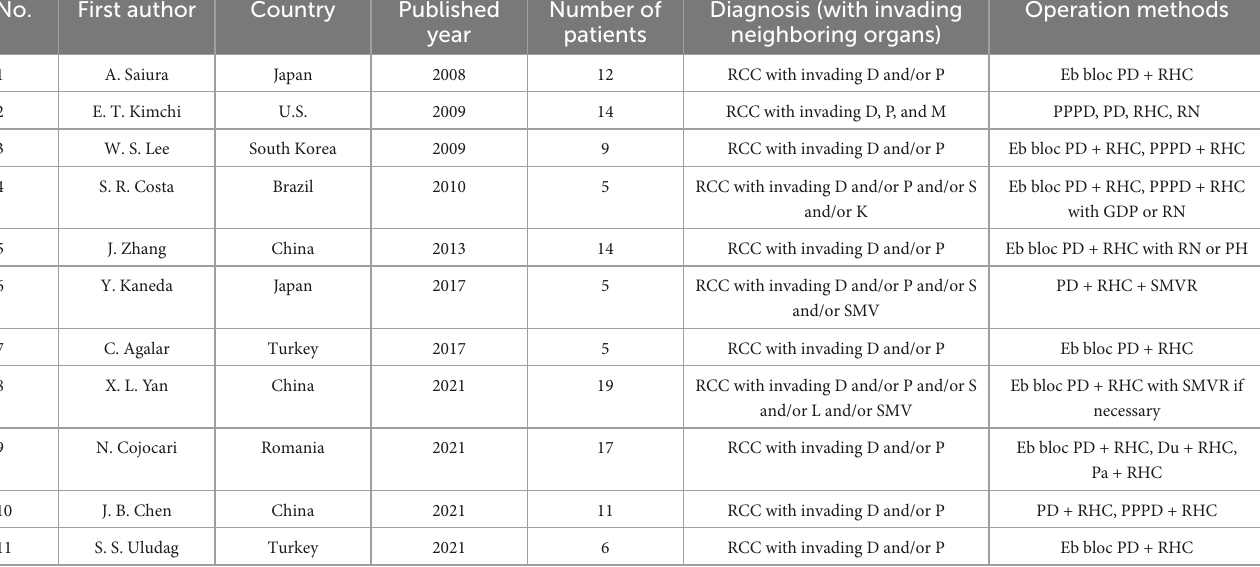
TABLE 1 The characteristics of included studies.